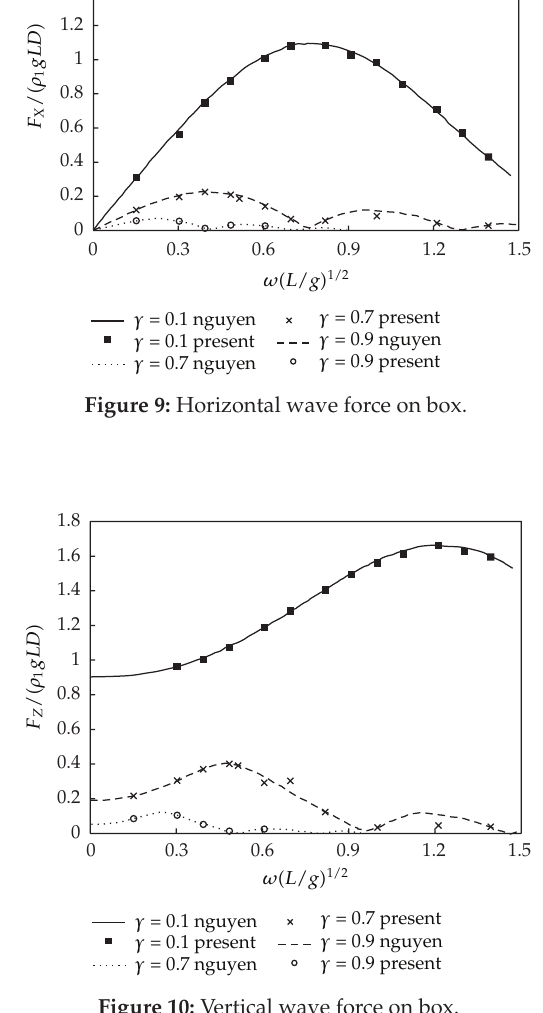
Figure 10: Vertical wave force on